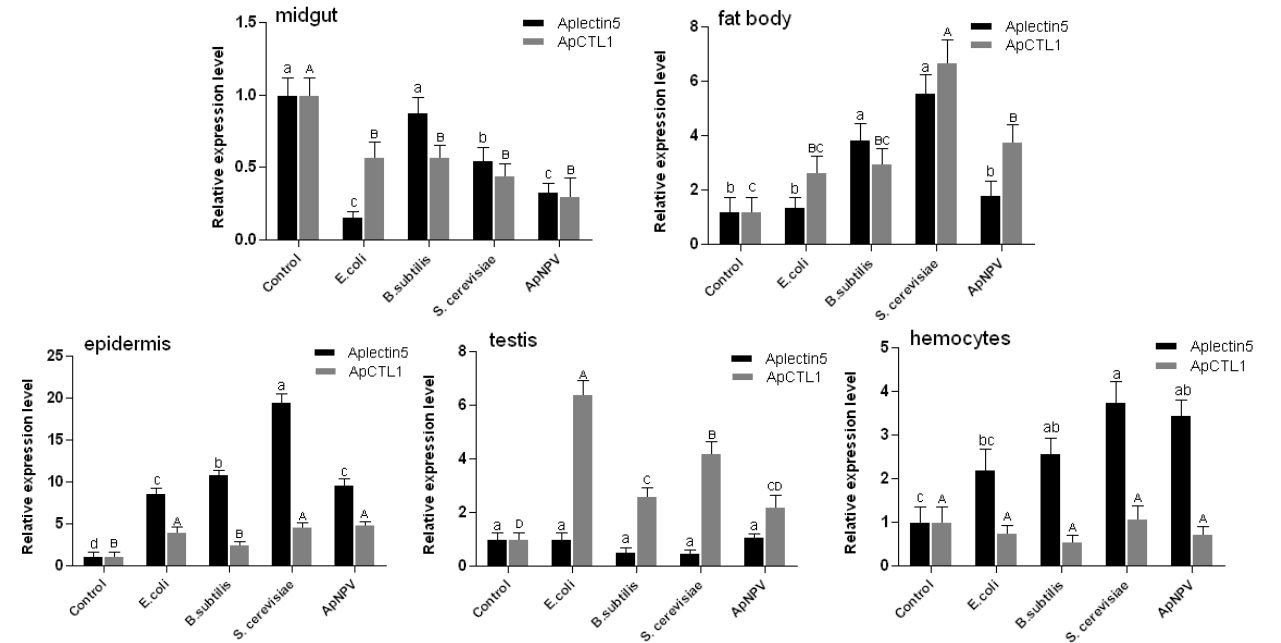
Figure 7. Expression of Aplectin-5 and ApCTL1 at 24 h postinfection in different tissues of A. pernyi pupae. Different letters indicate significant differences in expression, p < 0.05. Error bars indicate standard deviation of three biological